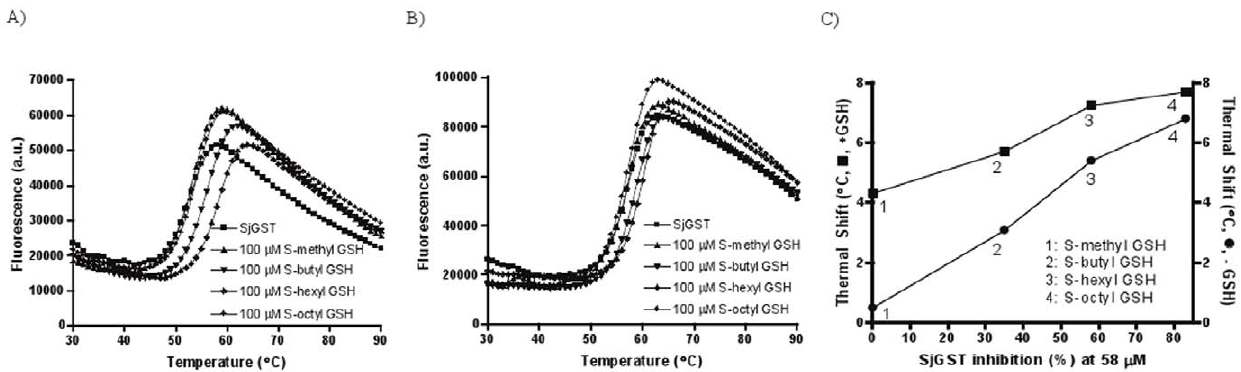
Figure 2. Thermal denaturation curves for Sj GST alone or with 100 m M S-alkyl GSH in the absence (A) and presence (B) of 2 mM GSH; (C) correlation between thermal shift at 100 m M alkyl-GSH and degree of inhibition against Sj GST. Thermal shifts, where applicable, represent the differences in T m between vehicle control and compound-containing samples, respectively.